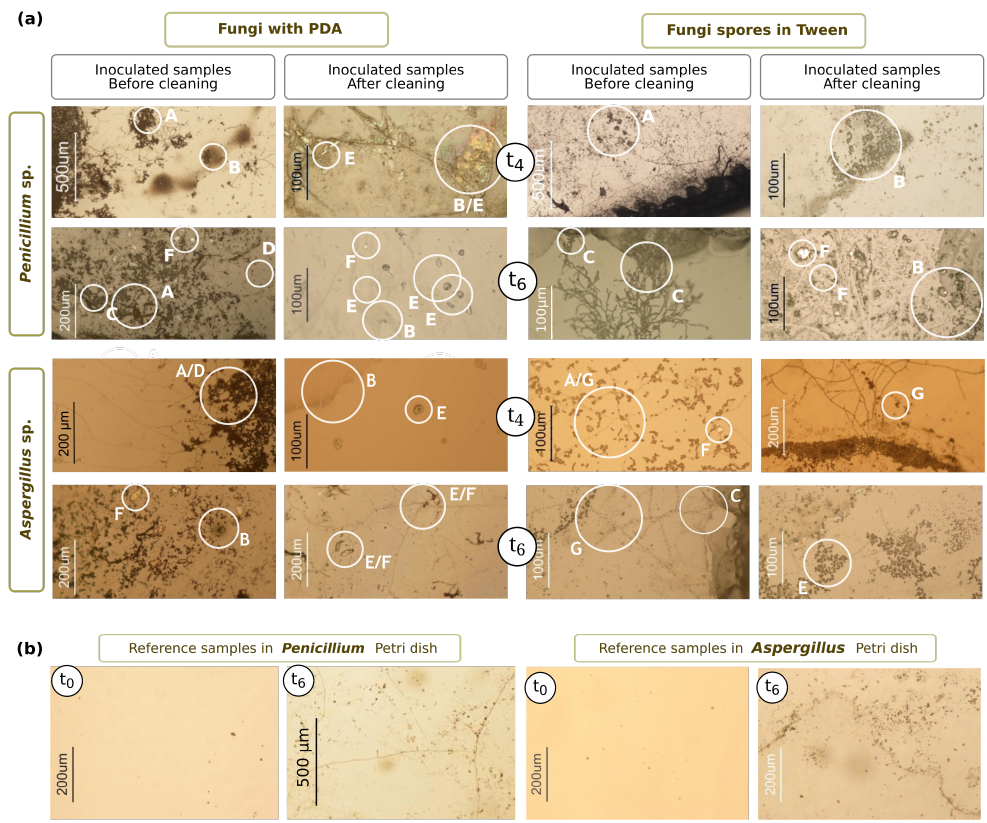
Figure 2. Optical microscopy results from ( a ) the inoculation of SPB-87 with Penicillium chrysogenum and Aspergillus niger , and of ( b ) the reference samples placed inside the same conditions of the inocu- lation environment. Legend: (A) clear biological colonisation/mycelium, (B) chromatic alterations (spots, stains, iridescence), (C) mycelium growth up to the edge, (D) denser mycelium near the PDA, (E) Etching/biopitting produced by hyphae, (F) crystal formation, (G) growth of mycelium from the